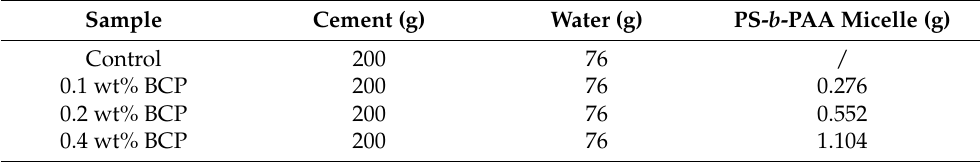
Table 1. Mix proportions of various PS- b -PAA (BCP) doped cement paste samples (mass in a unit of